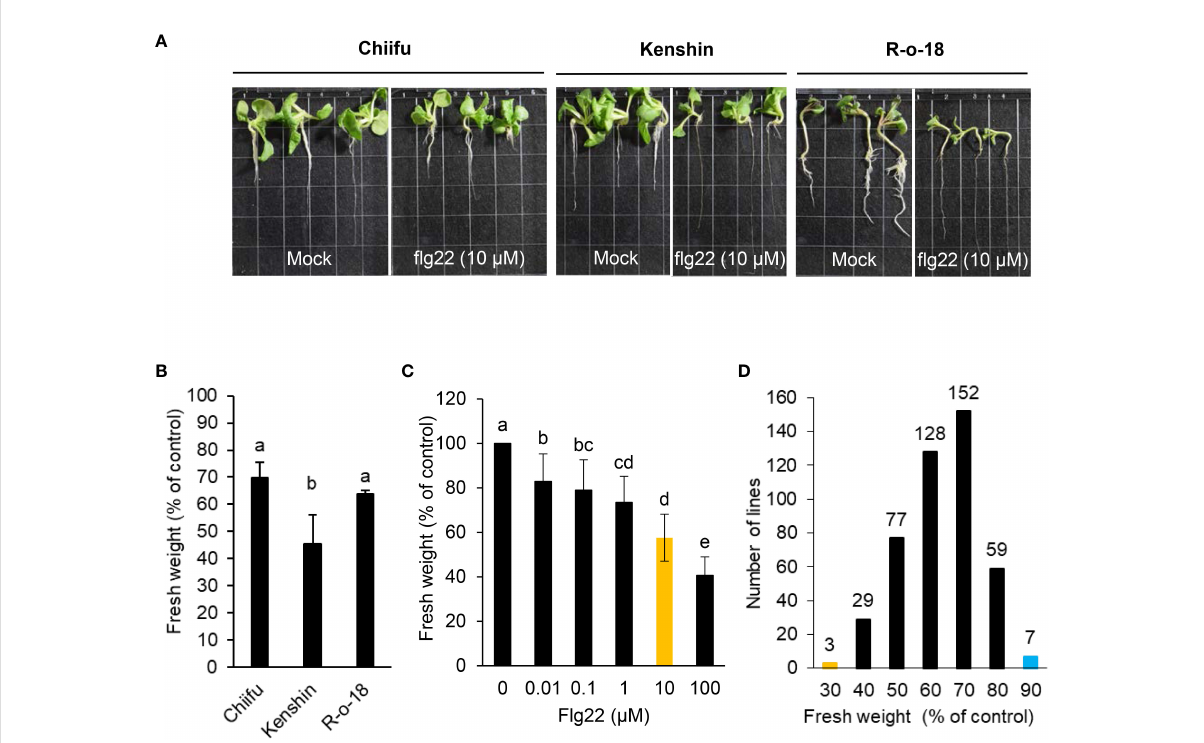
FIGURE 1 Effects of fl g22 on the growth of B. rapa inbred lines. (A, B) Six-day-old seedlings of inbred lines Chiifu, Kenshin, and R-o-18 were incubated for an additional 6 days in plates containing Murashige and Skoog (MS) agar medium with or without 10 µM fl g22. (C) Dose dependency of seedling growth inhibition. Six-day-old R-o-18 seedlings were incubated for an additional 6 days in liquid MS medium with or without fl g22. Error bars represent standard deviations (n = 9 seedlings). (D) Six-day-old seedlings of 455 B. rapa inbred lines were incubated for an additional 6 days in liquid MS medium containing H 2 O or fl g22 (10 µM). Different letters indicate signi fi cant differences among plant genotypes (B) or treatment (C) , respectively ( a = 0.05, one-way ANOVA and Tukey ’ s HSD test; SPSS